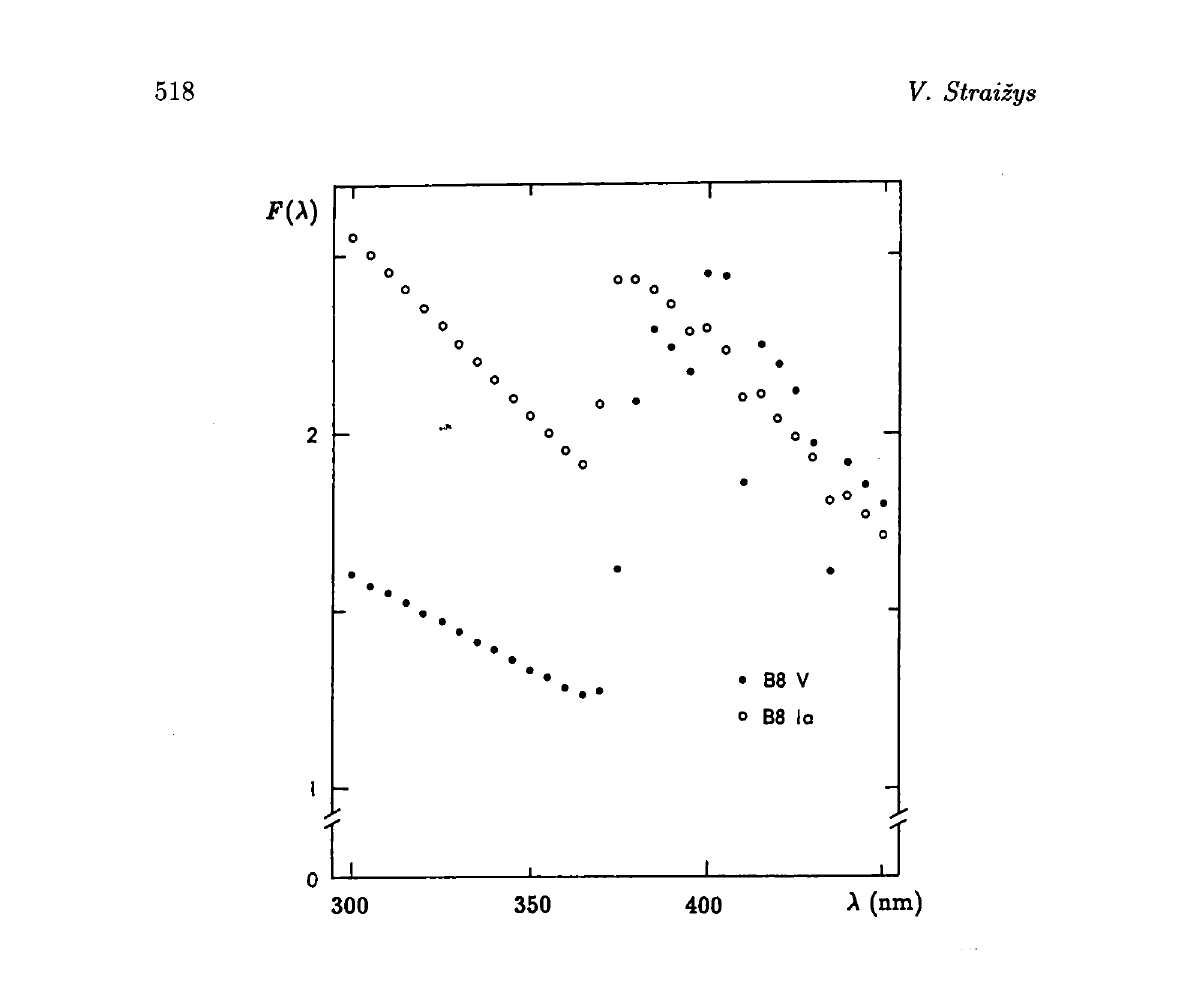
Fig. 7. The energy distribution in the region of the Balmer jump of a main sequence star and a supergiant of spectral class